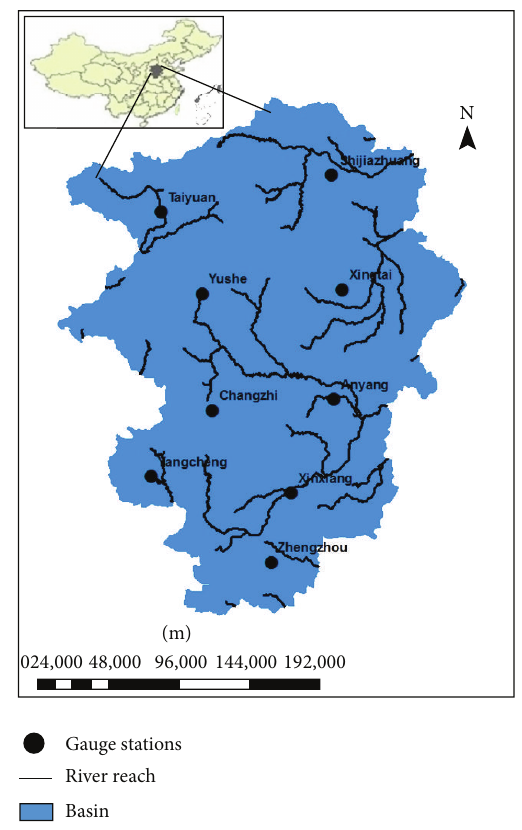
Figure 1: Locations of meteorological stations at Zhanghe River